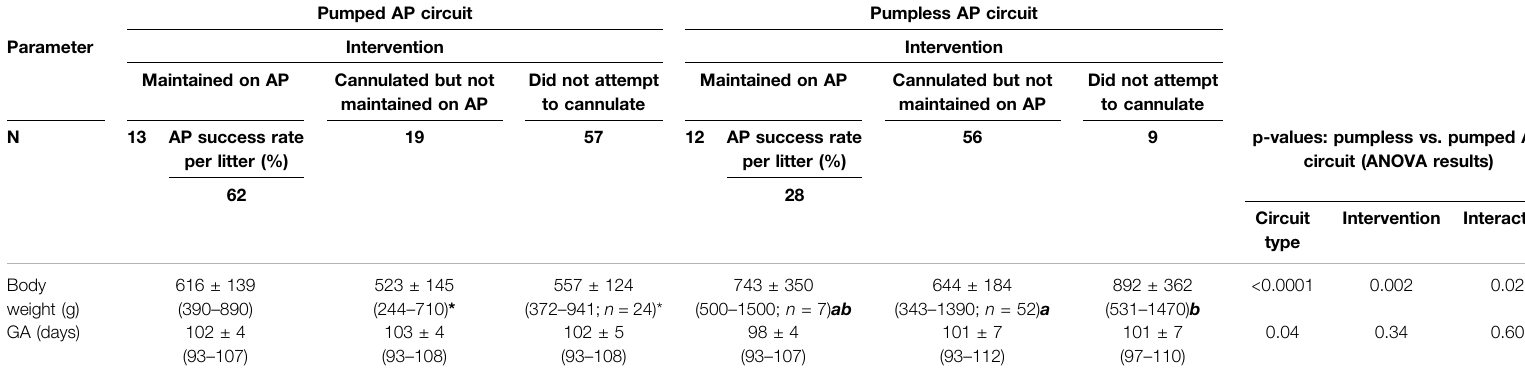
TABLE 1 | Summary of fetal pigs from pumped and pumpless AP circuits (Charest-Pekeski et al.,